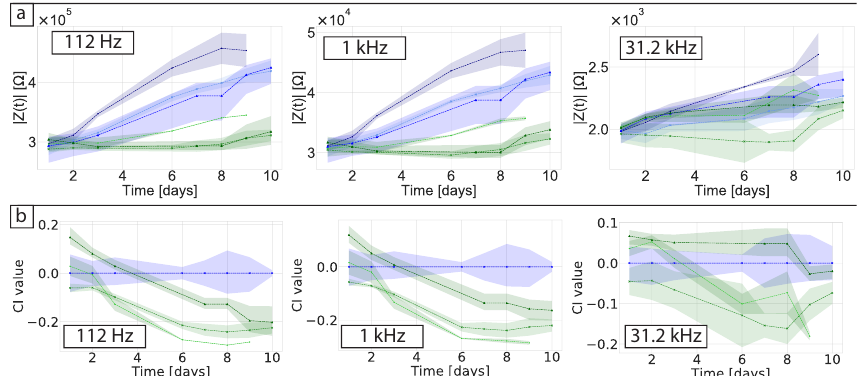
Figure 5. ( a ) Impedance magnitude and ( b ) cell index (CI) changes over time for measurements taken daily at 112 Hz, 1 kHz and 31.2 kHz while the electrodes were incubated in standard culture conditions. The impedance was normalised to the average of the samples containing collagen and DMEM + FBS. Blue lines are from wells containing collagen in DMEM + FBS medium and green lines are from wells seeded with 3 × 10 4 cells in collagen and medium. Shaded area shows minimum and maximum of the two